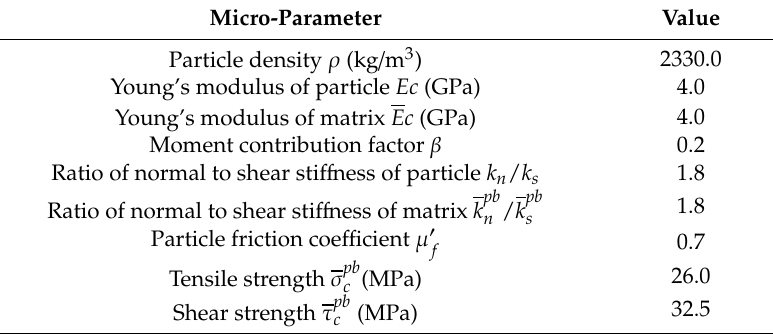
Table 1. Micro-constitutive parameters calibrated for rock